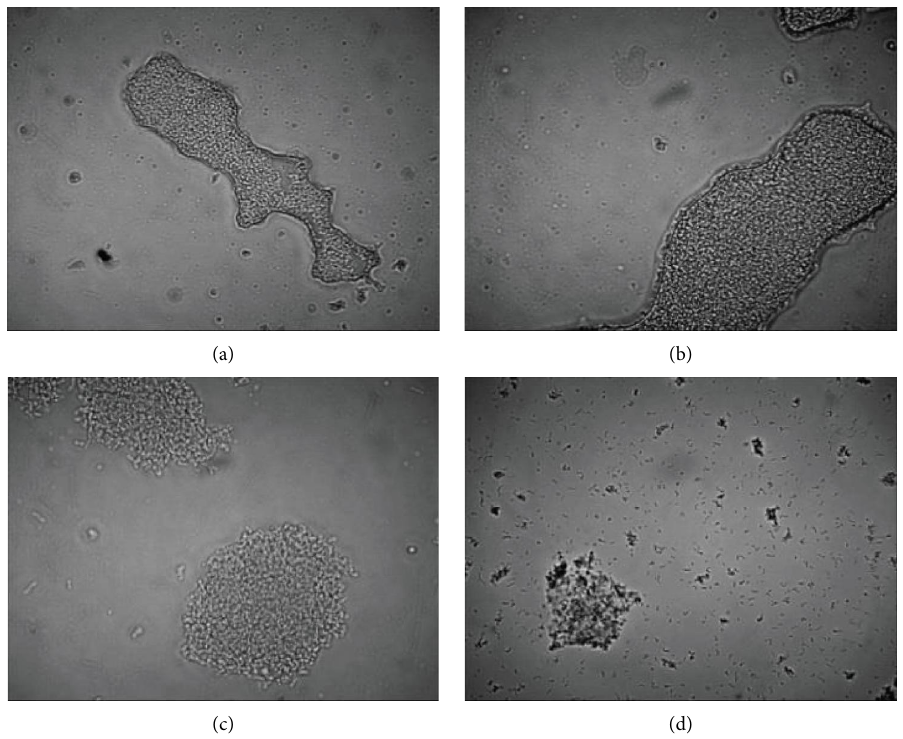
Figure 7: Microscopic appearance of hydrogel containing L. acidophilus FNCC 0051 (1300x magnifcation) during exposure to intestinal juice for (a) 0min, (b) 60min, (c) 90 min, and (d) 120min.